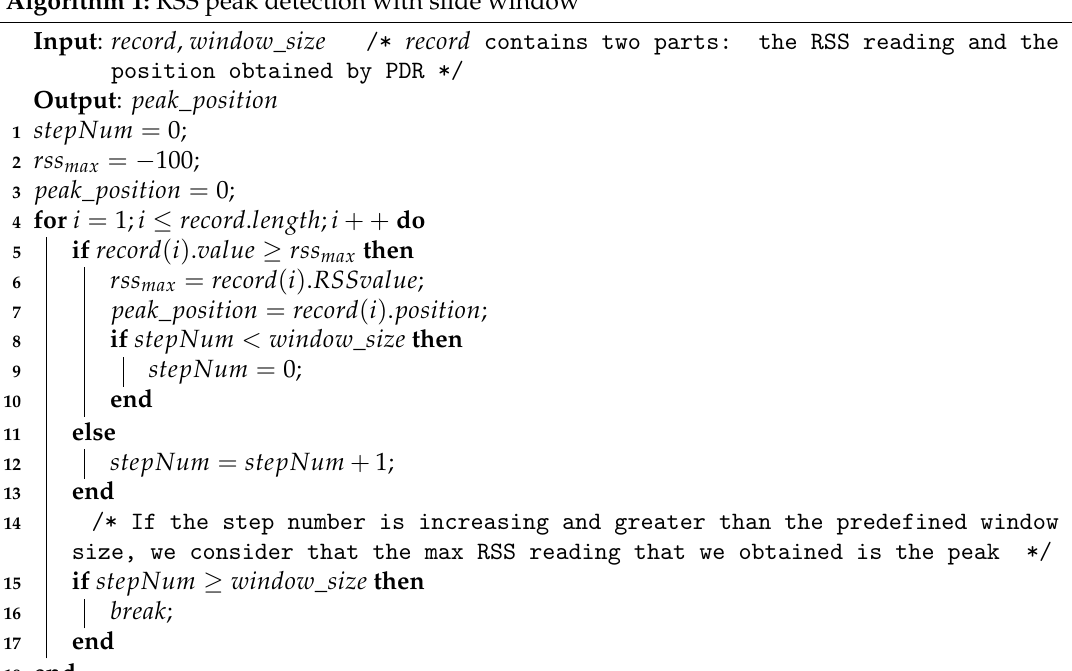
Algorithm 1: RSS peak detection with slide